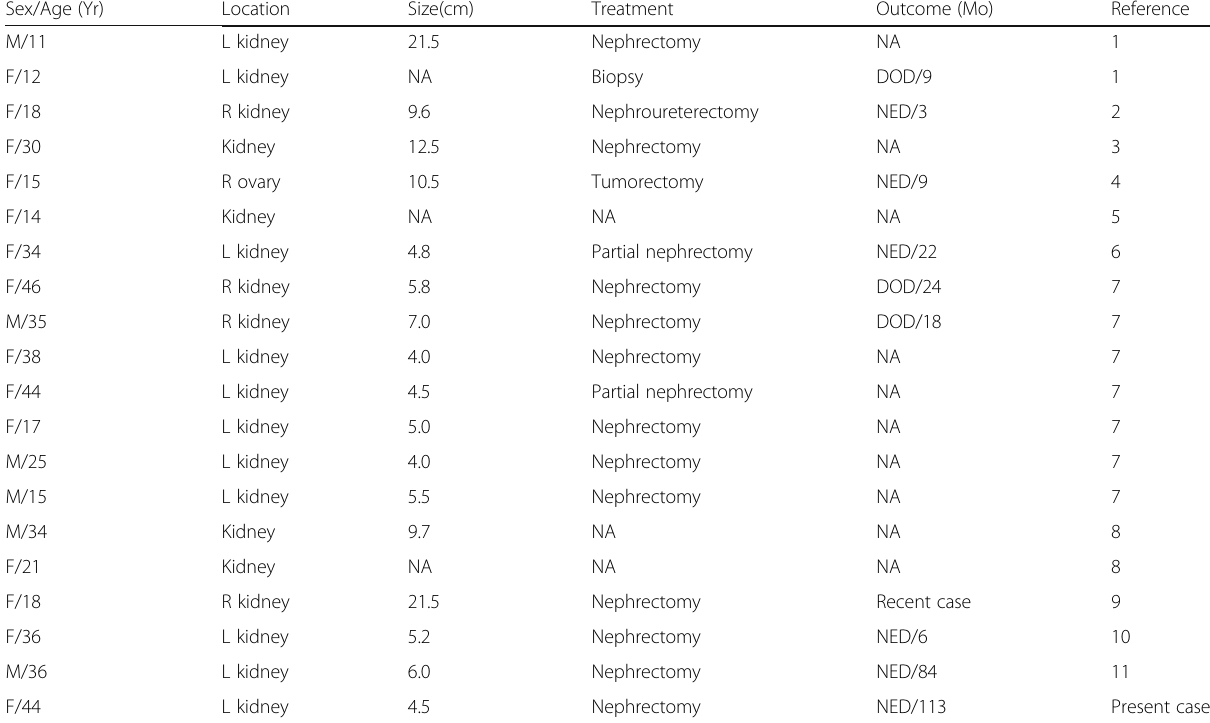
Table 1 Clinicopathological data for 19 reported cases of Xp11 TRC